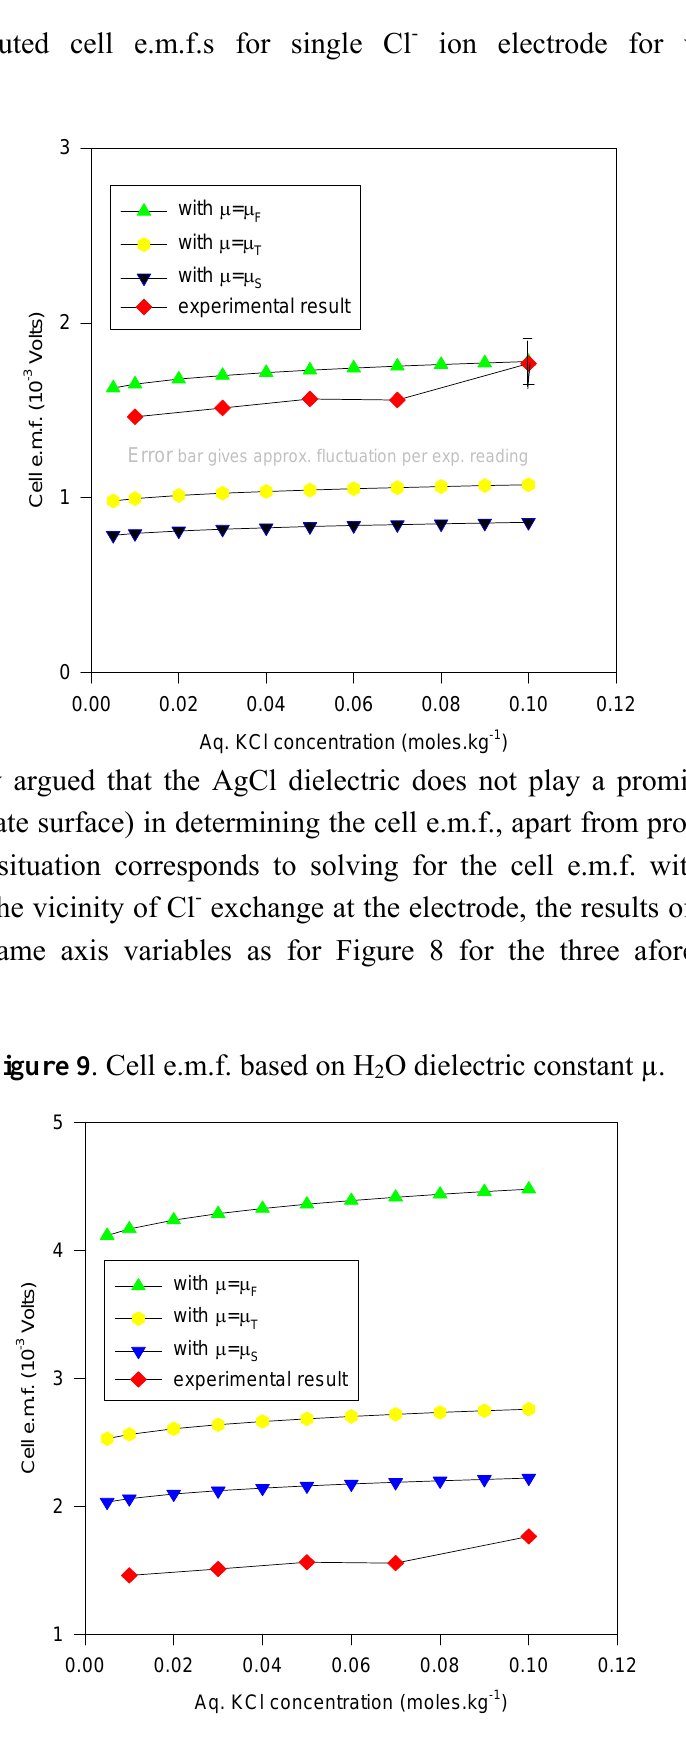
Figure 8. Computed cell e.m.f.s for single Cl - ion electrode for various µ and experimental data.